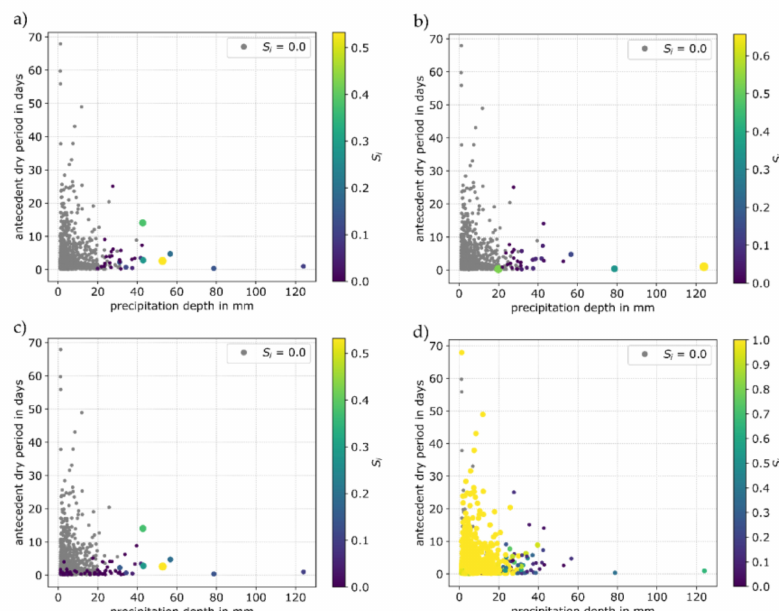
Figure 7. Results of storm event-based sensitivity analysis for the infiltration trench. Si depending on storm event characteristics (precipitation depth, antecedent dry period) and infiltration trench parameters: ( a ) Si for runoff volume and storage thickness; ( b ) Si for runoff volume and storage seepage rate; ( c ) Si for storage change/groundwater recharge and storage thickness; ( d ) Si for storage change/groundwater recharge and storage seepage